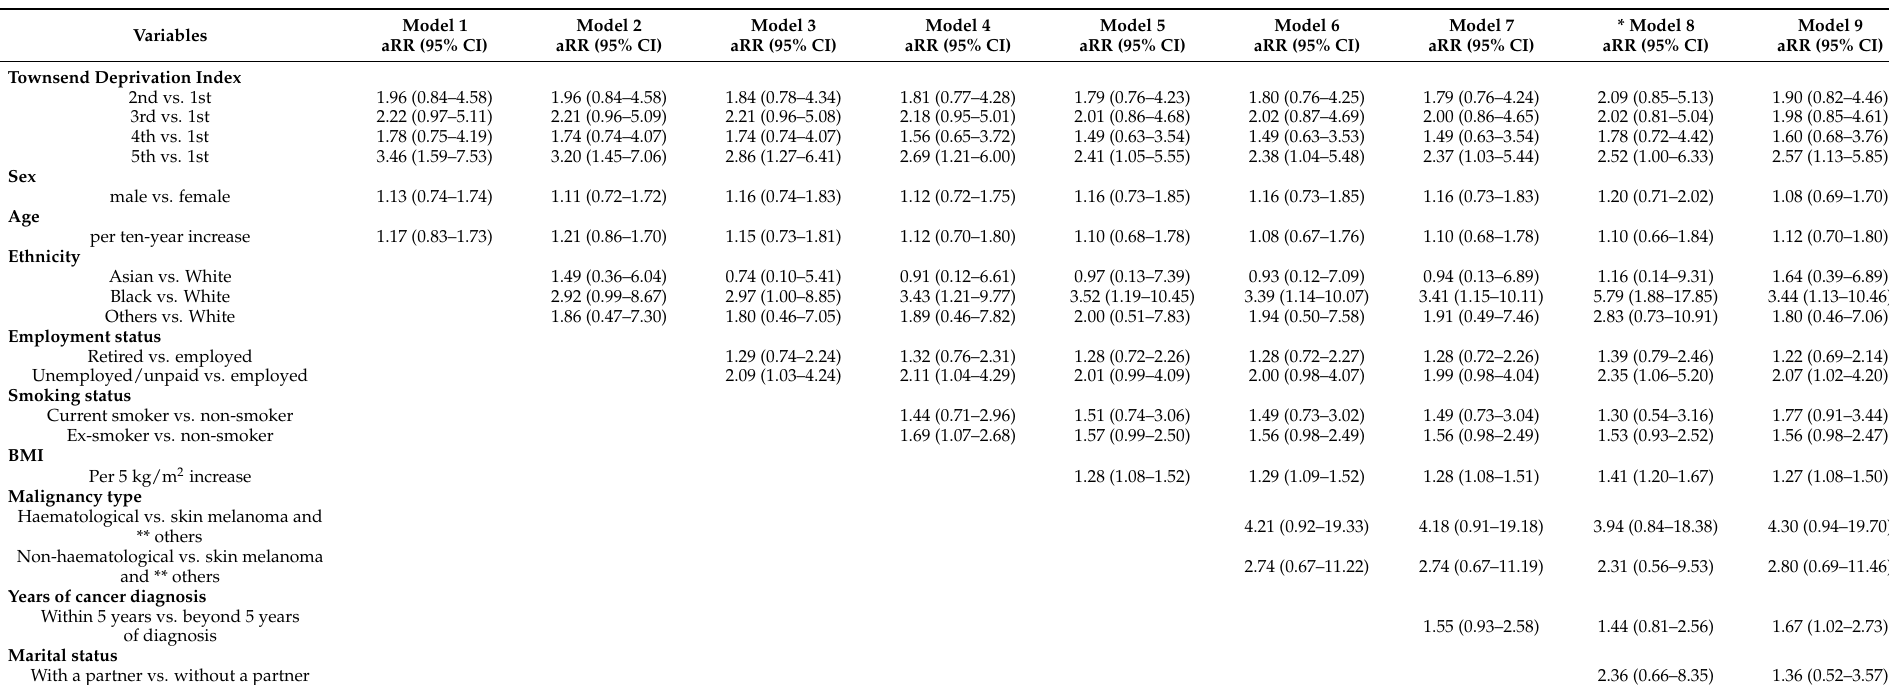
Table 3. Case-Cohort Control Study Adjusted Risk Ratios of Testing COVID-19 Positive among UK Biobank Incident Cancer Patients by Deprivation, Age, Sex, Ethnicity, Employment Status, BMI and Cancer Type ( N =